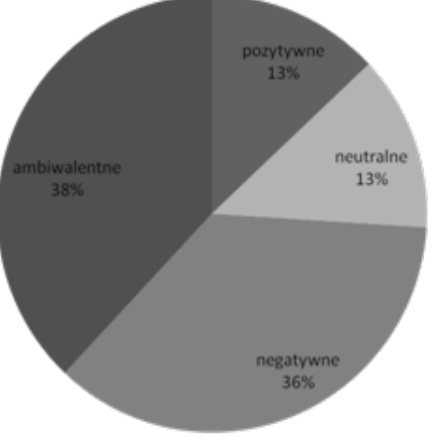
 Nasze dzieci po przyjściu do domu rozwijają sie jak dzieci urodzone w terminie, więc jesteśmy najszczę- śliwszymi rodzicami na ziemi.  Spotkało nas największe szczęście w życiu. Relacje rodziców o ze względu na znak emocji moż- na podzielić na cztery grupy: (1) zawierające tylko pozy- tywne emocje, (2) zawierające tylko negatywne emocje, (3) ambiwalentne czyli zawierające emocje zarówno pozytywne jak i negatywne oraz (4) neutralne czyli nie odnoszące się do emocji bezpośrednio. Rycina 1. Podział relacji rodziców ze względu na znak emocji